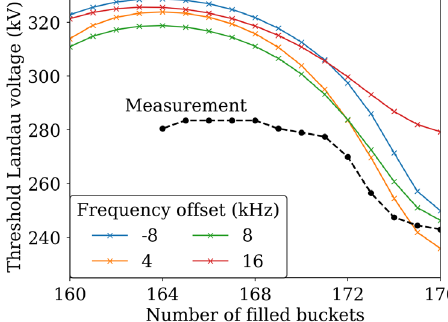
FIG. 8. Threshold Landau-cavity voltage for different fill patterns in the MAX IV 3 GeV as calculated for different frequency offsets of the HOM from resonance. The measured curve is also included for reference.